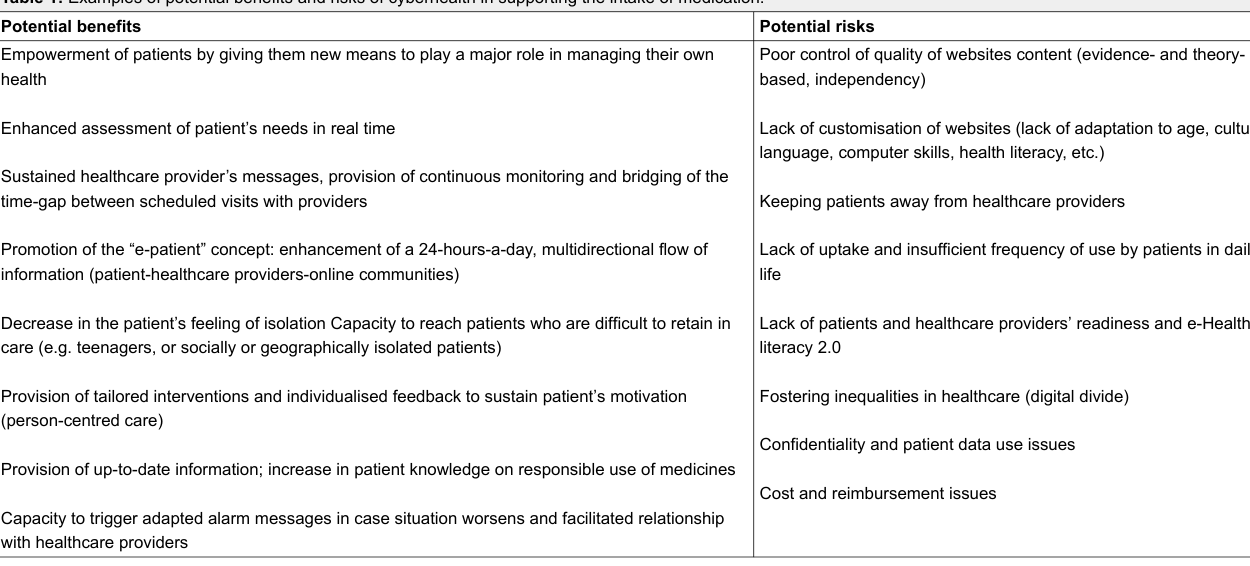
Table 1: Examples of potential benefits and risks of cyberhealth in supporting the intake of medication. Potential